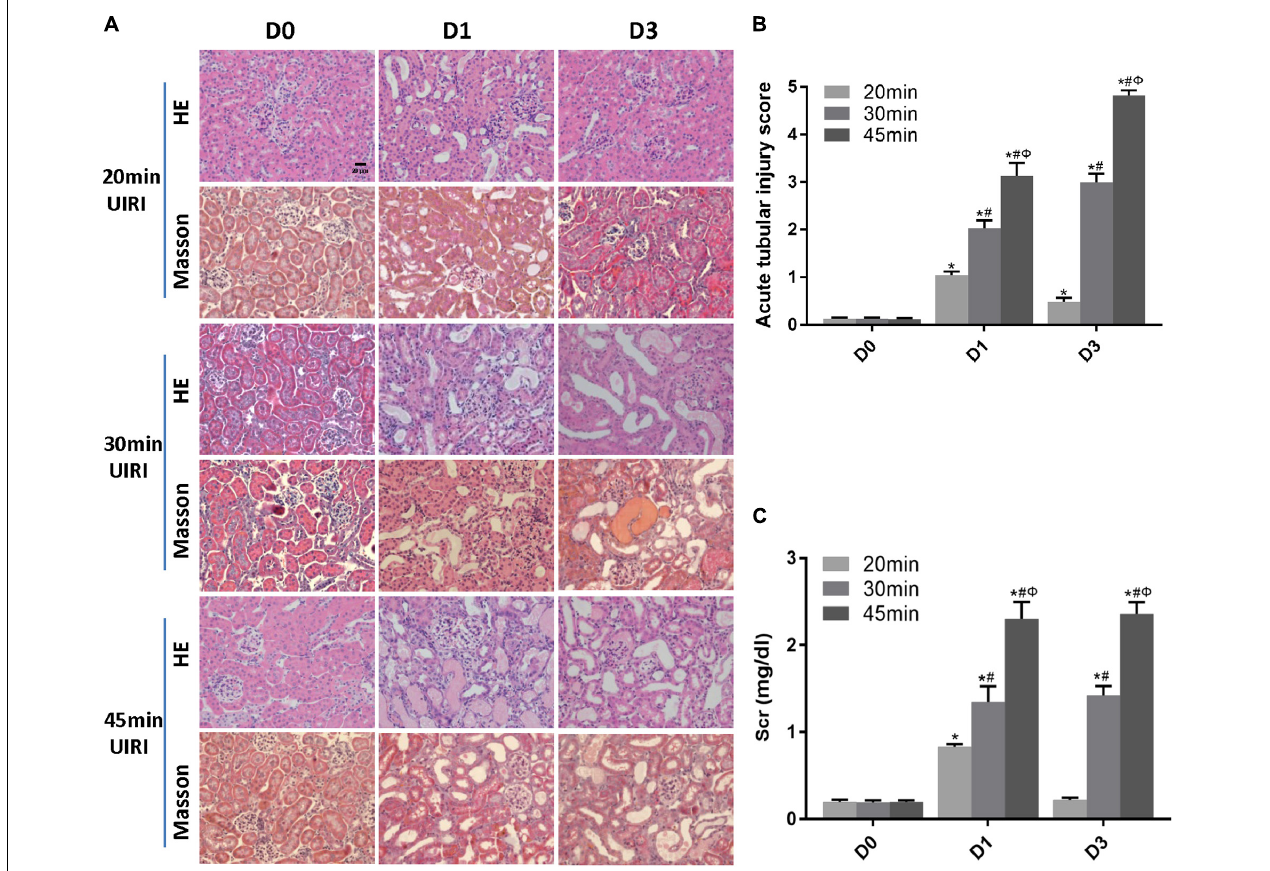
FIGURE 1 | Relationship between ischemia duration and severity of acute tubule-interstitial injury. (A) HE and Masson staining of kidneys during the acute phase of kidney injury (original magnification × 400; Scale bar, 20 µ m). (B) Acute tubular injury score of mouse kidneys during the acute phase of kidney injury. (C) Changes in Scr levels in mice during the acute phase of kidney injury. Data are presented as the means ± SEM of four experiments. n = 6; ∗ P < 0.05 vs. the control group. # P < 0.05 vs. the 20 min-ischemia group. (cid:56) P < 0.05 vs. the 30 min-ischemia